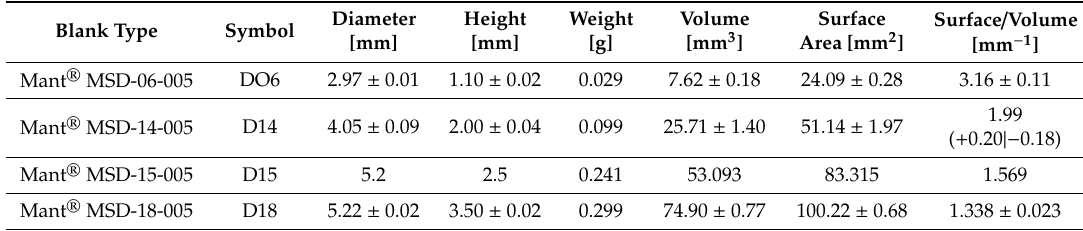
Table 2. Dimensions of PCD samples with grain size of 5 µ